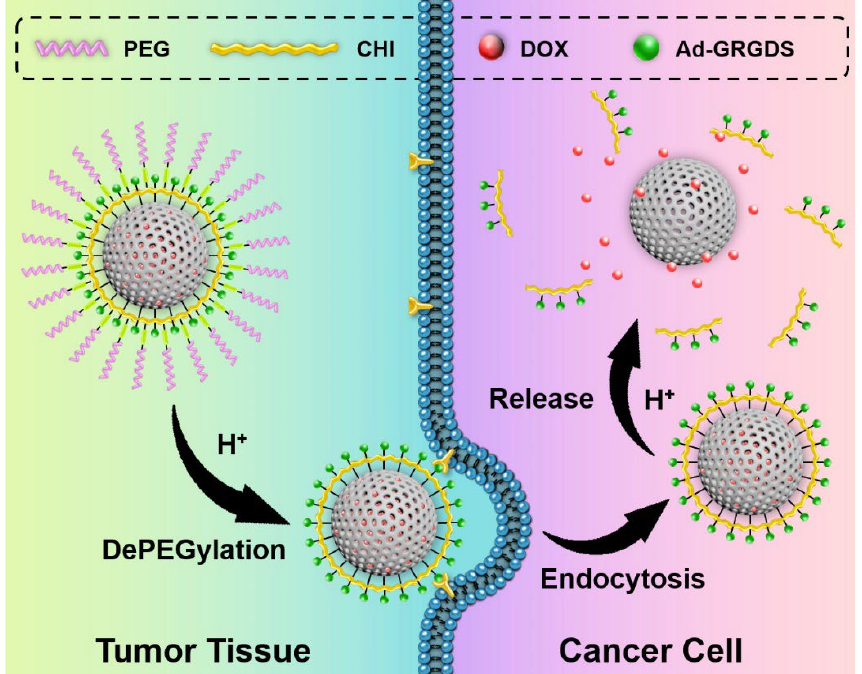
Figure 3. Schematic illustration of dual-pH-sensitive “tumor-triggered targeting” PEG/CHI/MSN- based DDS with a controlled intracellular DOX release behavior. Reprinted with permission from Ref. [73]; Elsevier.